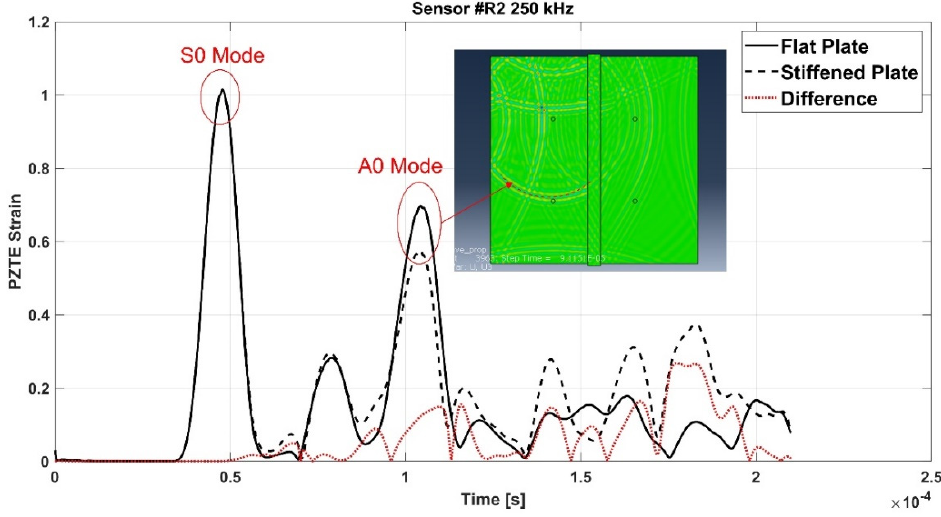
Figure 9. A 0 mode at 250 kHz carrier detected by the R2 sensor—aluminum stiffened plate.